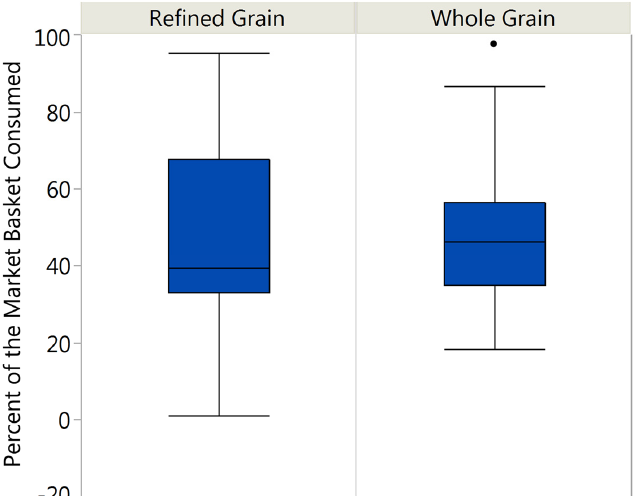
Figure 1. Range of Market Basket Consumption. Consumption of the refined grain market basket ranged from 1.1% to 95.1% with the average consumption being 44.7% and a standard error of the mean of 7.8. Consumption of the whole grain market basket ranged from 18.1% to 97.5% with the average consumption being 47.9% and a standard error of the mean of 3.0.